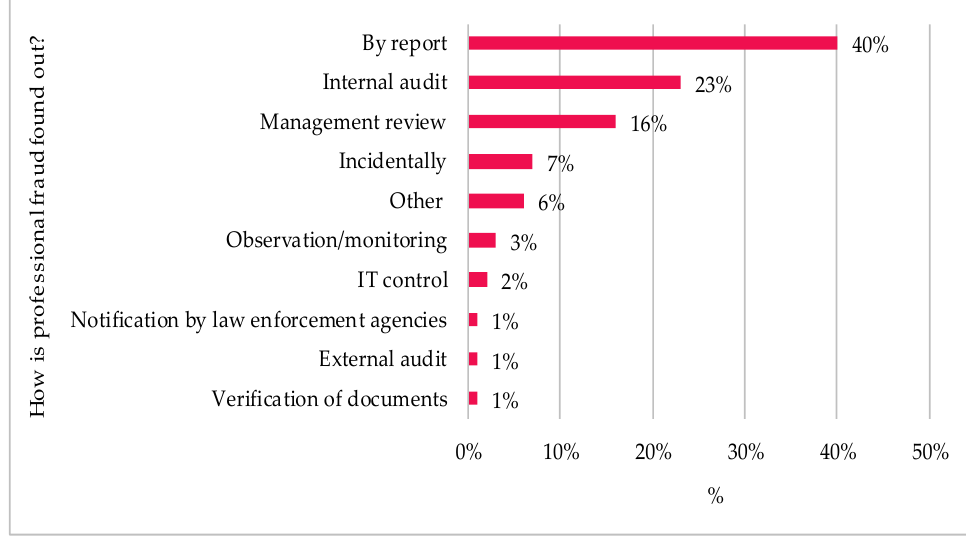
Figure 5. How is professional fraud discovered? Source: based on Occupational Fraud 2022, A report to the nations .